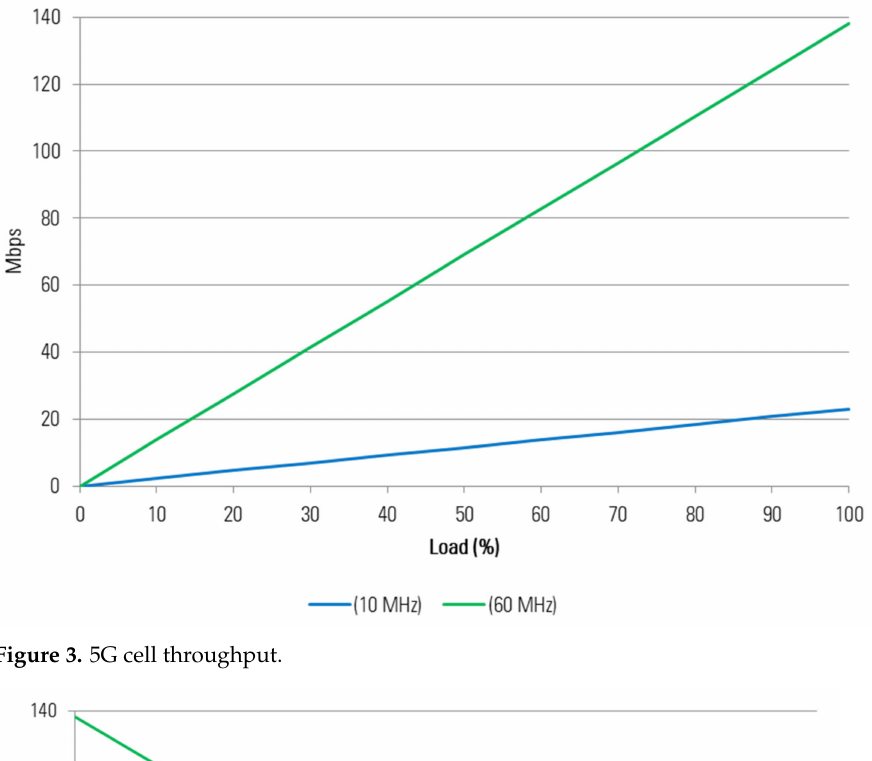
Figure 3. 5G cell throughput.